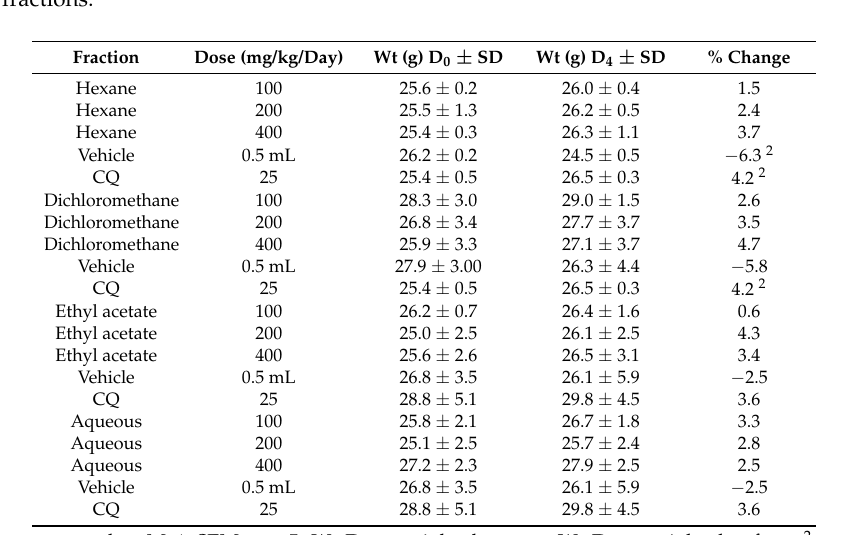
Table 4. Body weight of Plasmodium berghei- infected mice before and after administration of solvent fractions.